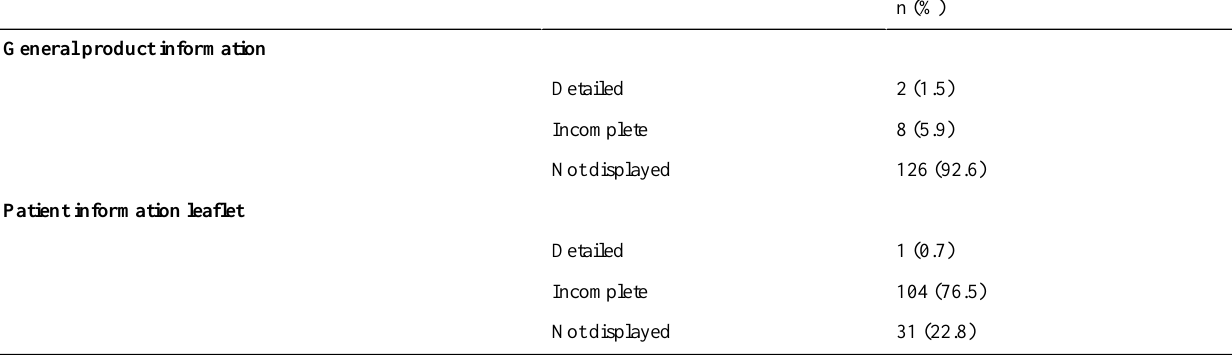
Table 2. Information availability on marketed medicines (N=136).